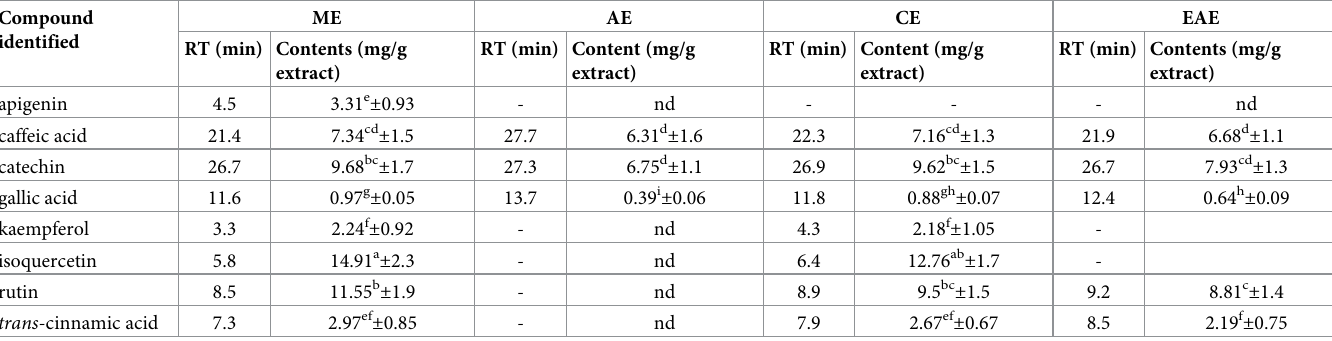
Data represent mean ± standard deviation (SD) of three biological replicates. All mean values in the same column with different letters are significantly different from each other at P <